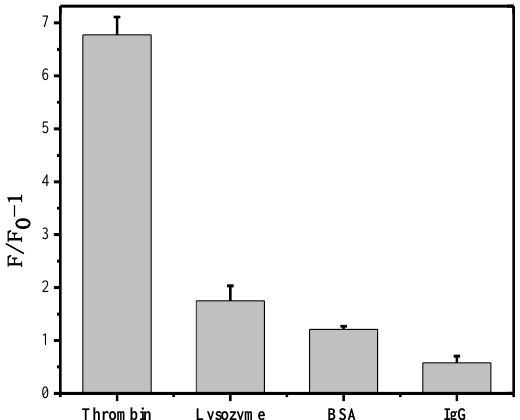
Figure 6. The fluorescence intensity of aptamer (10 nM)-GO (20 µ g/mL) in the presence of other proteins (BSA, Ig G, and lysozyme, the concentration was 0.001 nM for every protein). The number of samples was 5.